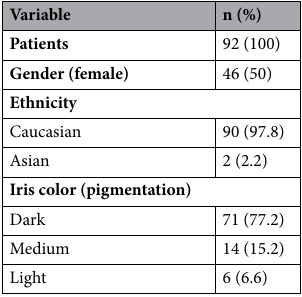
Table 1. Demographic variables